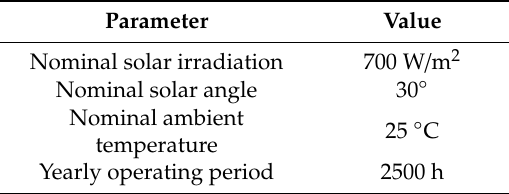
Table 3. Input data for the yearly system